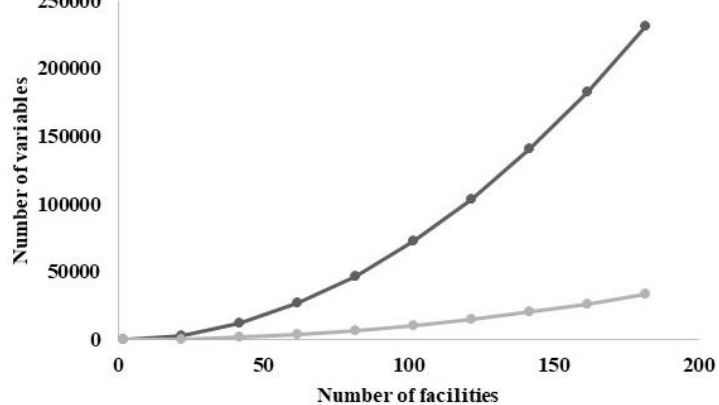
Figure 3. CLITraP-HTF number of decision variables after applying the DRP on n , T, q and δ.